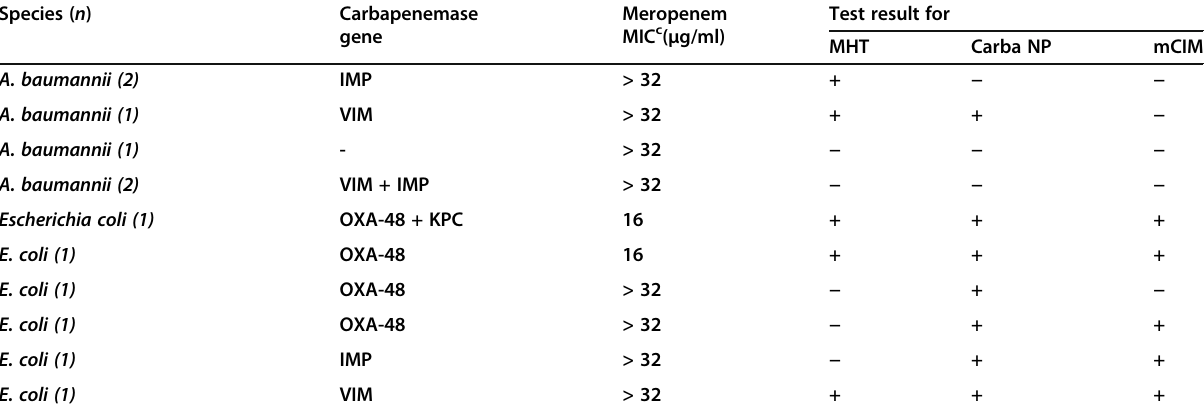
Table 3 The results of MHT a , Carba NP, and mCIM b for isolates tested ( n = 122) (Continued) Species ( n